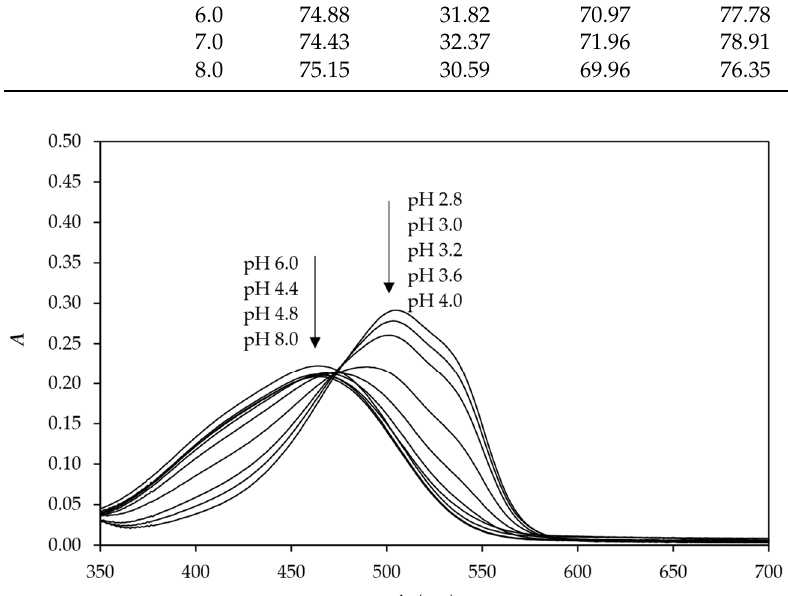
Table 5. Colour fastness to commercial and domestic washing using methods A1S and A1M* (* method A1M was performed only on sample CT_CO_D_C).